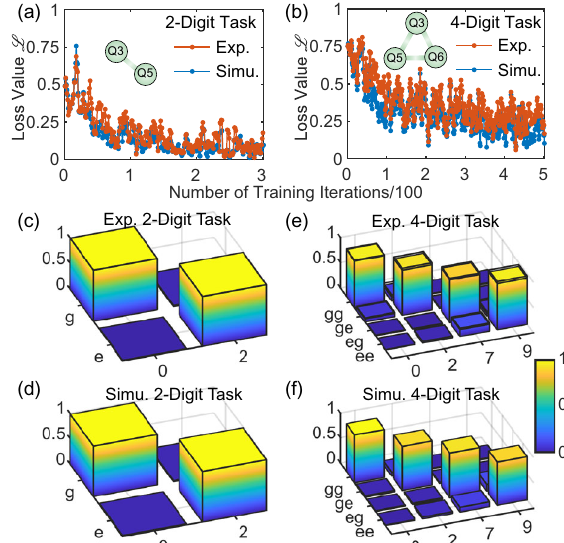
Fig. 2 Results of training the quantum end-to-end model. a , b The typical training process of the end-to-end model. For better clarity, all data points are averaged over the neighboring four points. c – f The classi fi cation performance of the trained model. The horizontal labels show the digits to be classi fi ed, while the vertical labels show the majority vote of the computational basis measure- ment results. The hollow bars (nearly invisible) in the experimental results ( c , e ) correspond to the standard deviation of multiple repeated measurements. c , d Experimental and simulation results for the 2-digit classi fi cation task, respectively. The averaged accuracies for the classi fi cation are 0.986 ± 0.001 and 0.982 in the experiment and the simulation, respectively. e , f The 4-digit classi fi cation of the QNN. The averaged accuracies are 0.894 ± 0.015 and 0.889 in the experiment and the simulation, respectively.